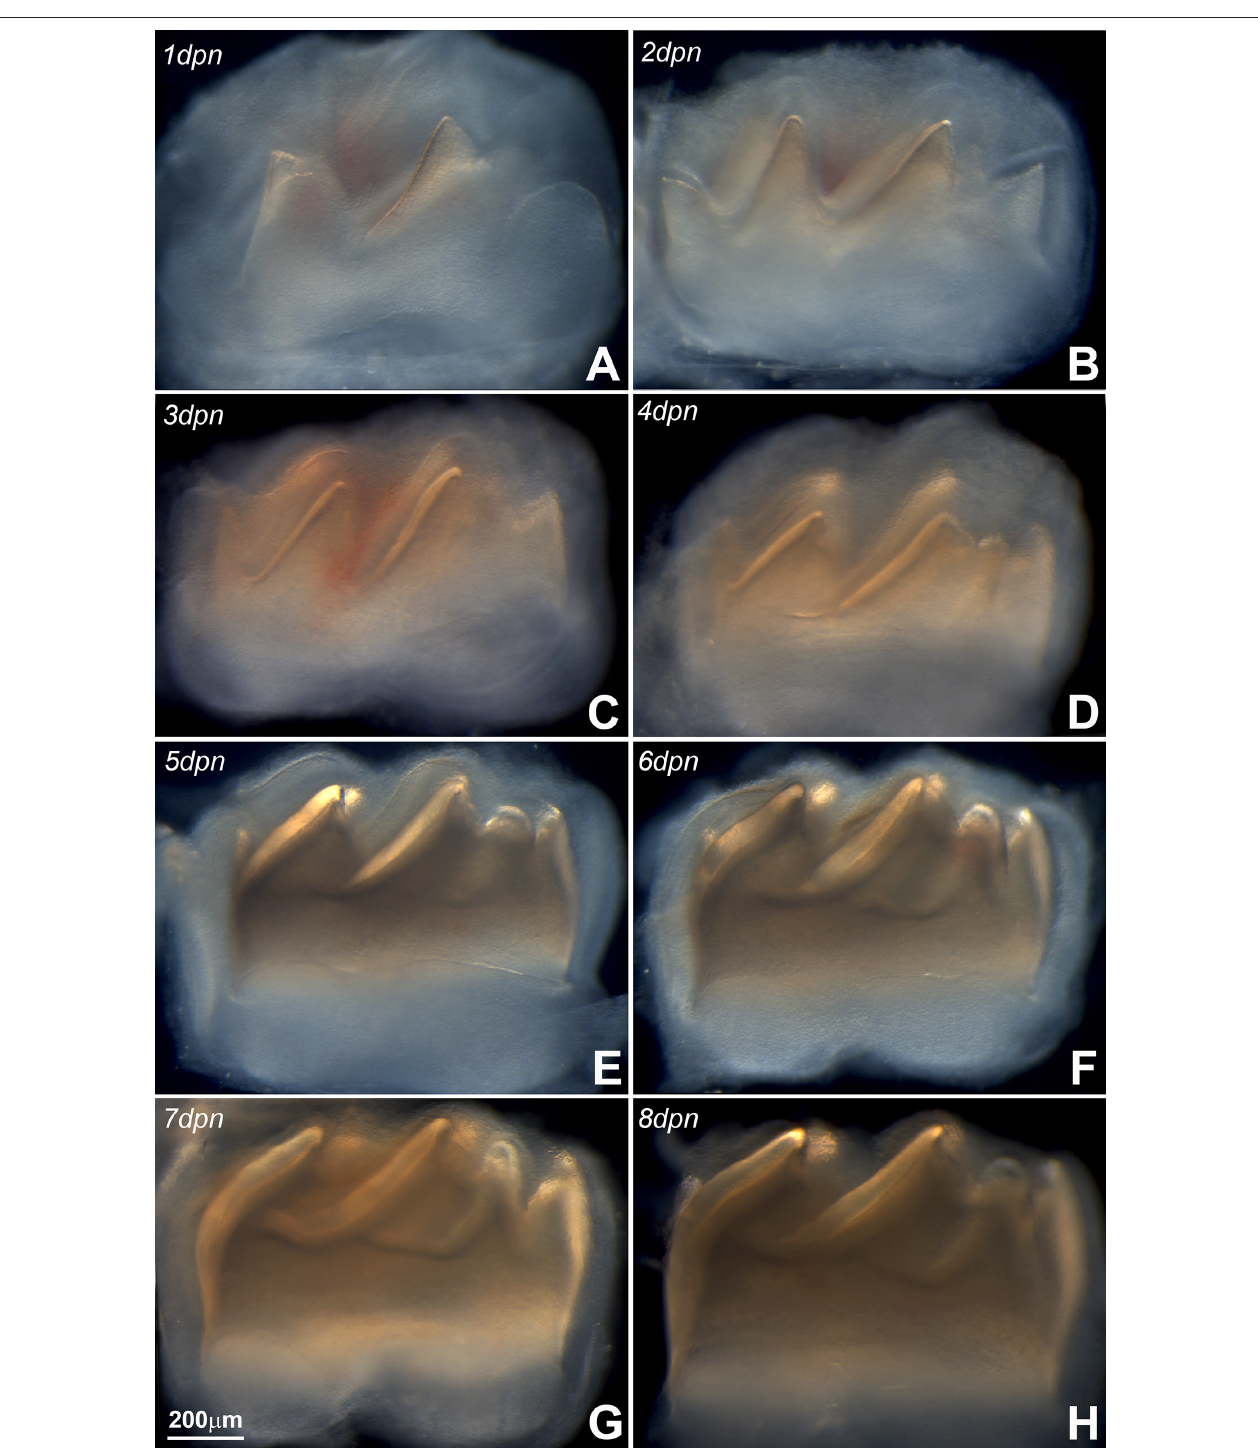
FIGURE 1 | Panel (A) represents the mandibular molar at postnatal day (pnd) 1, (B) is pnd 2, (C) is pnd 3, (D) is pnd 4, (E) is pnd 5, (F) is pnd 6, (G) is pnd 7, and (H) is pnd 8. During the first 8 days of postnatal mouse molar development, the mineralized portion of the crown dentin continuously increased in height, while the length of the crown remained fairly unchanged. Note the gradual increase in the thickness of the enamel layer (identified in Figure 2F ).